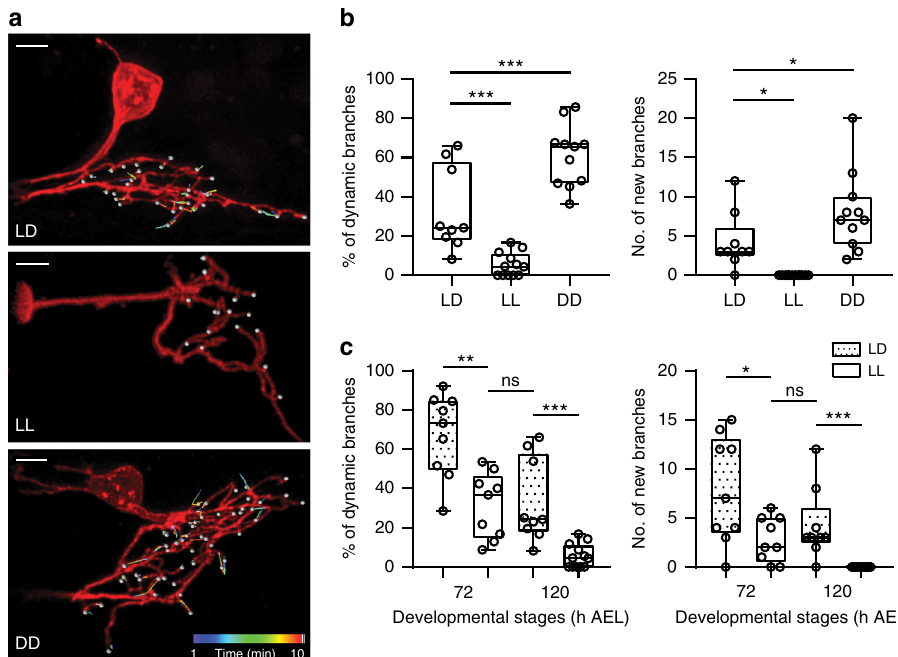
Fig. 4 Experience-dependent modi fi cation of the dynamic state of LNv dendrites. a Representative tracking trajectories generated by movements of dynamic fi lopodia in single-labeled LNvs collected at 120 h AEL from larvae cultured in light dark (LD), constant light (LL), or constant darkness (DD). Scale bar, 5 μ m. b Differential visual experiences provided by LL or DD during larval development generate opposite effects on dendrite dynamics in LNvs. Compared to LD, the percentage of dynamic branches, as well as the number of newly appeared branches, signi fi cantly increases in DD but decreased in LL. n = 9, 12, and 11 for LD, LL, and DD, respectively. Statistical signi fi cance was assessed by one-way ANOVA with Dunnett post hoc test. Dynamic branches (Left), ANOVA: F 2, 29 = 39.441, P < 0.001; Dunnett: P < 0.001, LD vs others. New branches (Right), ANOVA: F 2, 29 = 14.85, P < 0.001; Dunnett: P = 0.021, LD vs LL; P = 0.044, LD vs DD. c Compared to the LD group, young LNvs (72 h) cultured in LL have signi fi cantly reduced dendrite dynamics, close to the levels observed in mature LNv (120 h) cultured in LD. n = 9, 9, 9, and 12 for 72LD, 72LL, 120LD, and 120LL, respectively. Statistical signi fi cance was assessed by two-tailed Student ’ s t -test. Dynamic branches (Left): t 16 = 4.012, P = 0.001, 72LD vs 72LL; t 19 = 4.297, P < 0.001, 120LD vs 120LL; t 16 = 0.194, P = 0.849, 72LL vs 120LD. New branches (Right): t 16 = 2.59, P = 0.02, 72LD vs 72LL; t 19 = 4.101, P < 0.001, 120LD vs 120LL; t 16 = 1.017, P = 0.324, 72LL vs 120LD. Data are presented as box plot (box, 25 – 75%; center line, median) overlaid with dot plot (individual data points). ns, not signi fi cant; *P < 0.05, **P < 0.01, ***P <